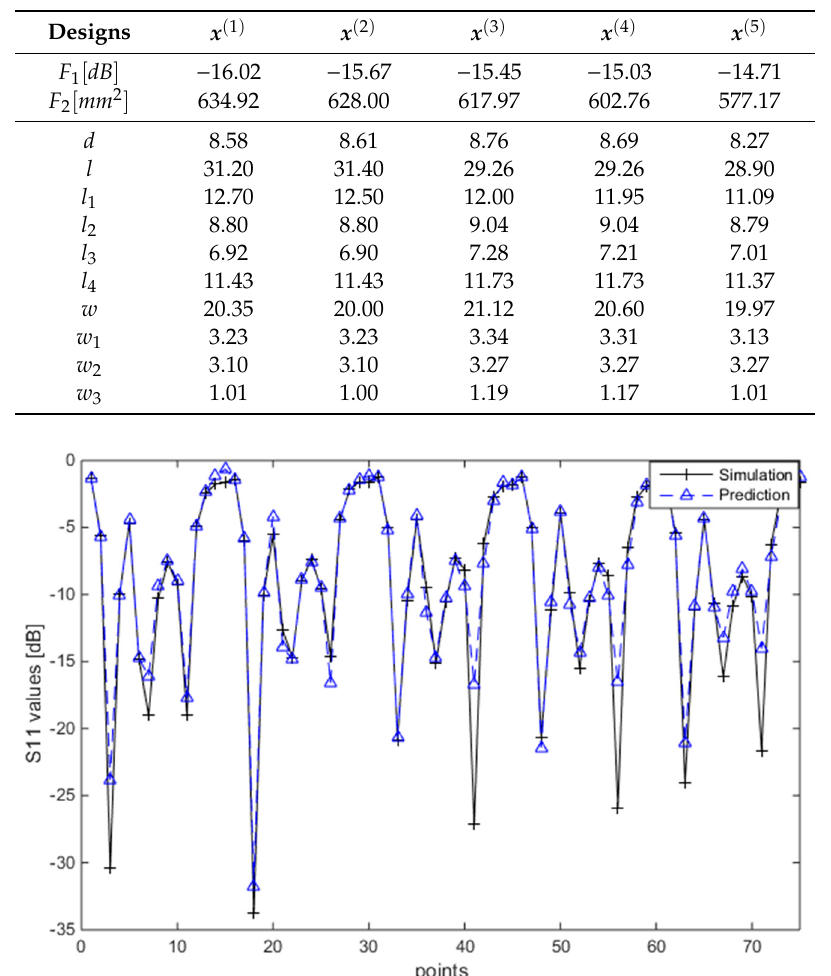
Figure 12. Simulation and prediction S 11 for the Pareto-optimal designs in Table 3.